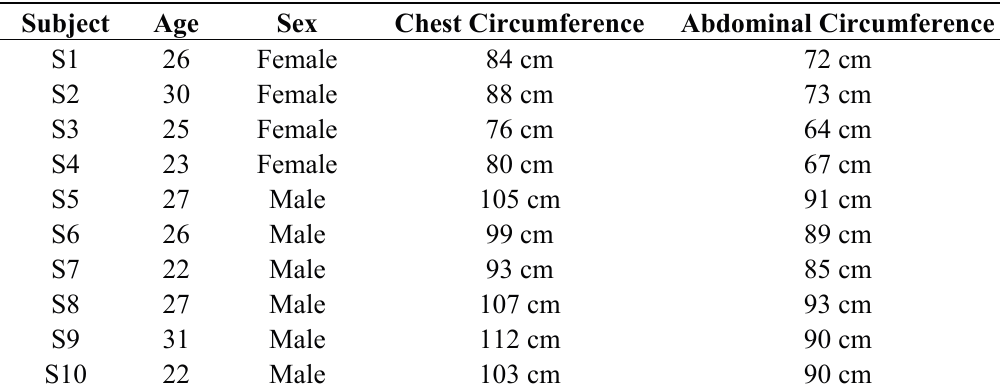
Table 1. Anthropometric data of the study